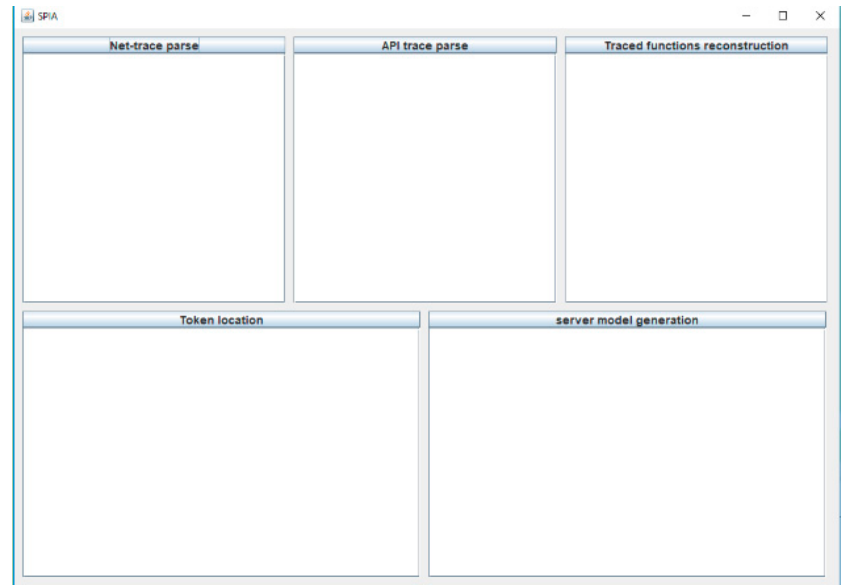
Figure 20. Graphical User Interface (GUI) of SPIA.